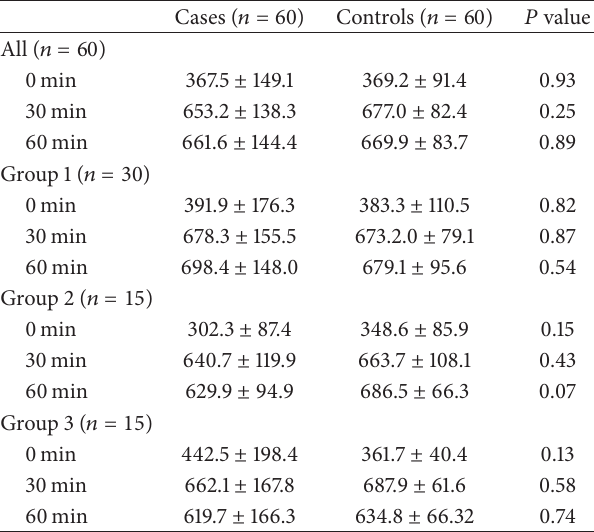
Table 5: Comparative cortisol values to cosyntropin after LT-4 replacement therapy between cases and their age-matched controls